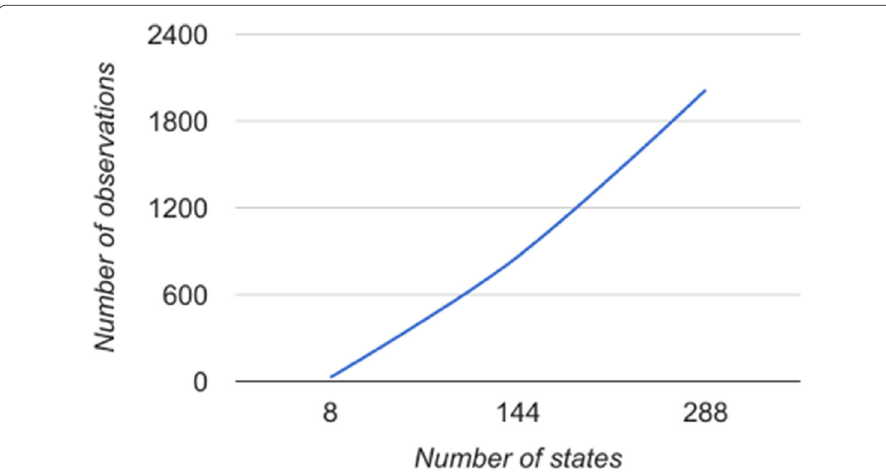
Fig. 2 Minimum number of observations needed versus the number of states. Figure 2 plots the minimum number of observations versus the number of states. The novice agent (8 states) needs a little amount of observations to cover all the actions that could be taken from every state (24 observations). The intermediate agent (144 states) needs 864 observations to cover all the actions that could be taken from every state. The advanced agent (288 states) needs the biggest number of observations to cover all the actions that could be taken from every state (2016